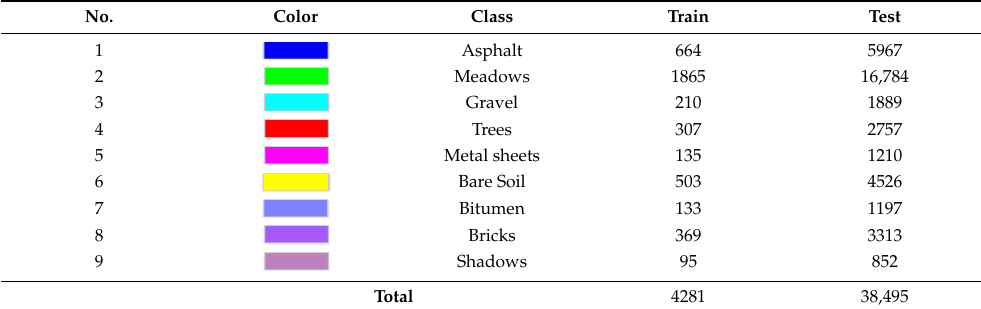
Table 1. The information on UP dataset, including number of training and test samples. No. No. No. Color